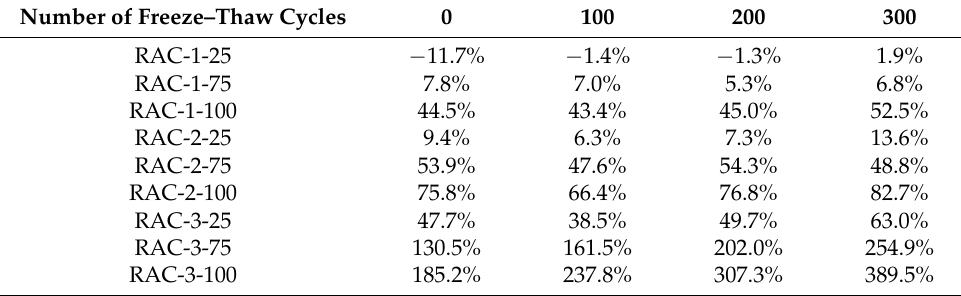
Figure 11. The 28-d carbonation depth of NAC and RRAC after 0–300 times of freeze–thaw cycles. Table 2. Growth rate of carbonation depth for RRAC with different replacement rates relative to NAC after 0–300 times of freeze–thaw